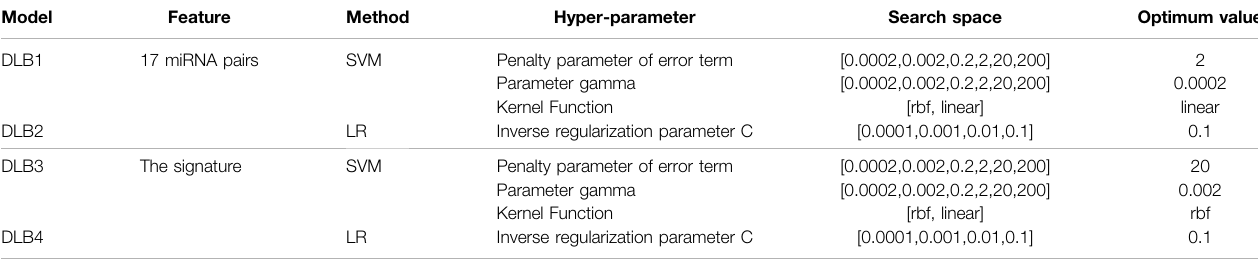
TABLE 2 | Hyper-parameter search space considered for all models and optimized hyper-parameter values in the four models. Model